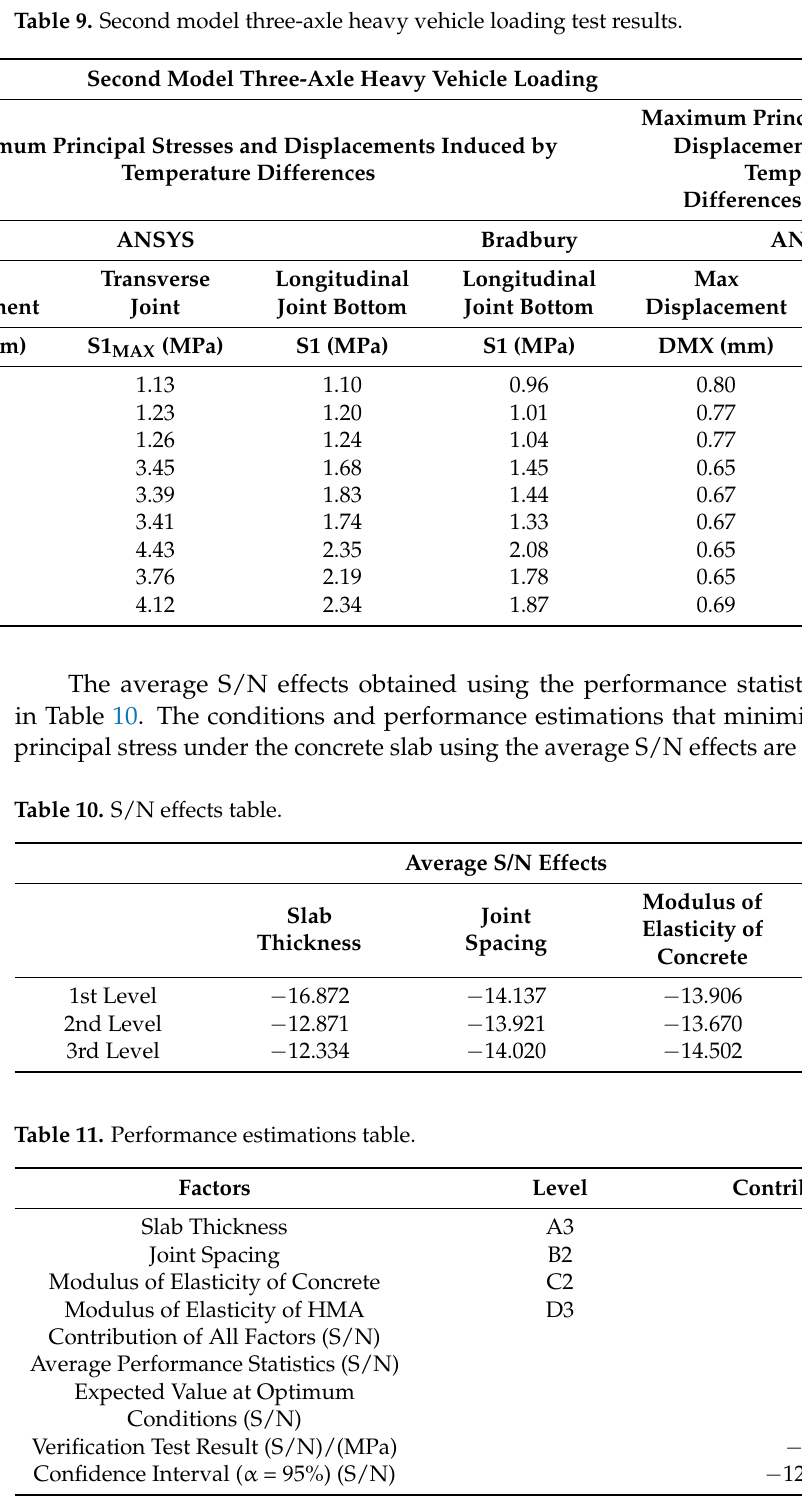
Table 9. Second model three-axle heavy vehicle loading test results.